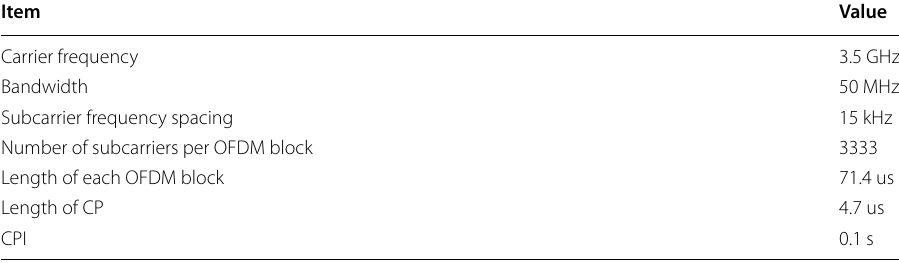
Table 2 Stationary scatter parameters